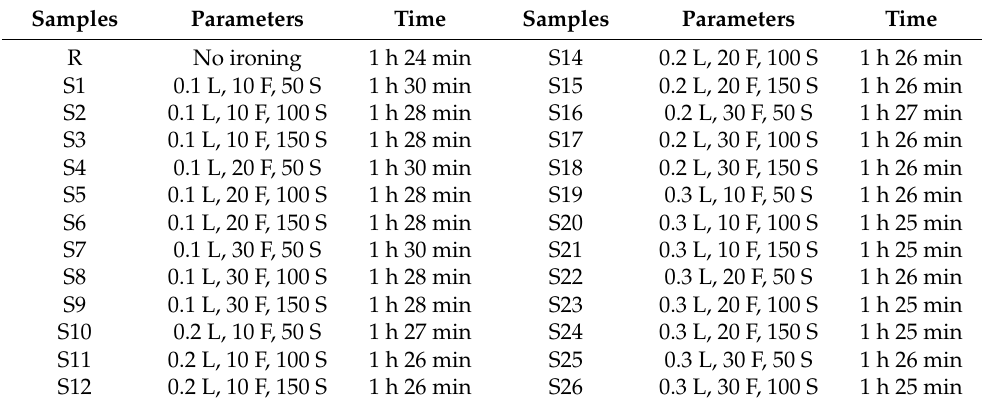
Table 2. Ironing parameters (R = reference; L = ironing line spacing; F = ironing flow; S = ironing speed). Samples Parameters Time